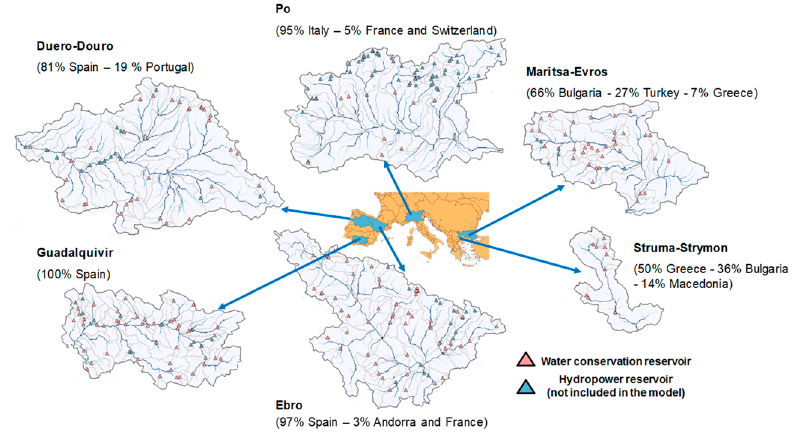
Figure 2. Basins under analysis. Table 1. Main characteristics of the basins under